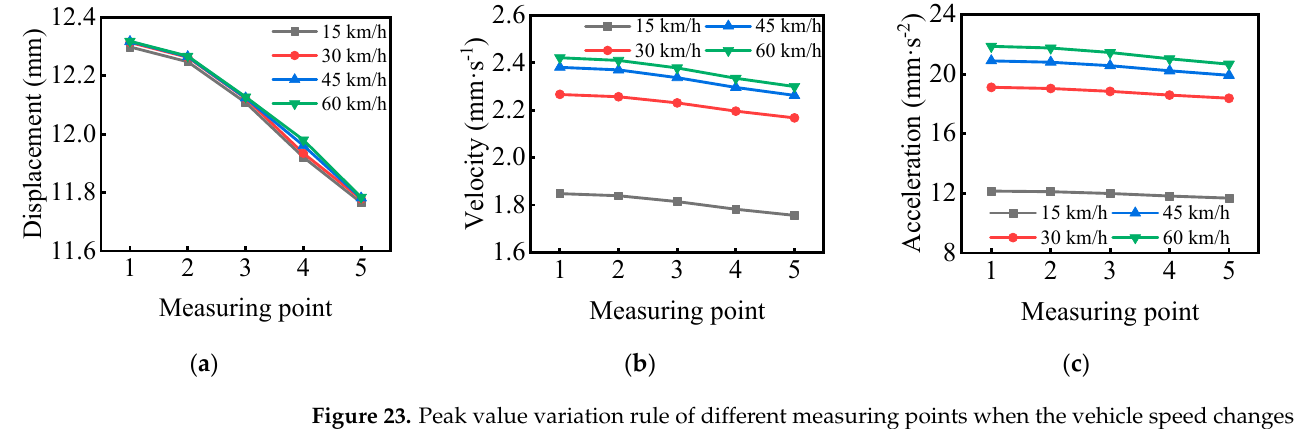
Table 7. Results of peak displacement, velocity, and acceleration at the mid − span measuring point when the vehicle speed changes.